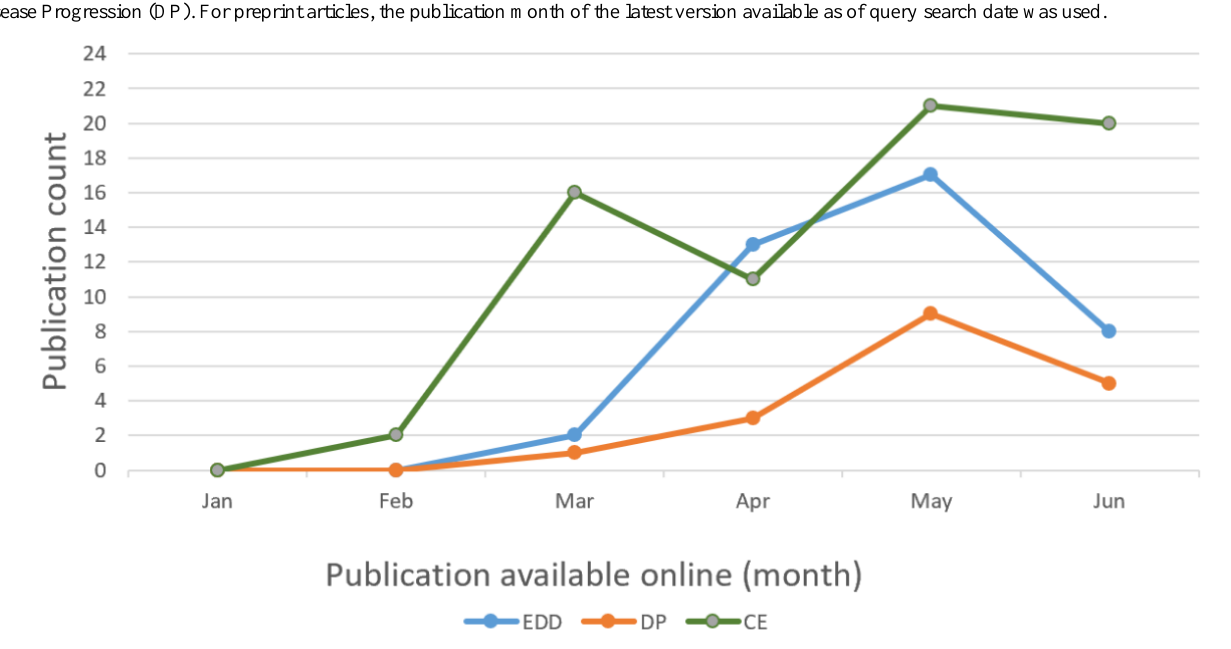
Figure 2. Over time (trend analysis) of COVID-19 studies focused on the application of artificial intelligence techniques that were made available online in 2020, categorized into the following 3 themes: (1) Computational Epidemiology (CE), (2) Early Detection and Diagnosis (EDD), and